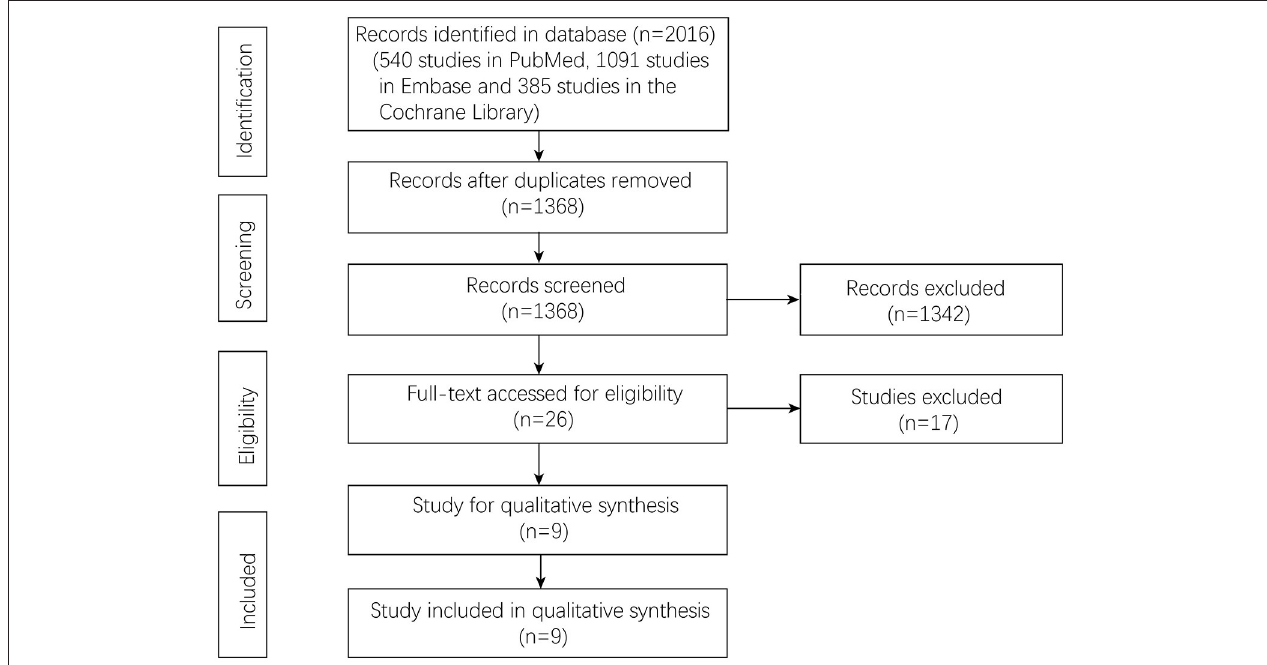
FIGURE 1 | Flowchart of study